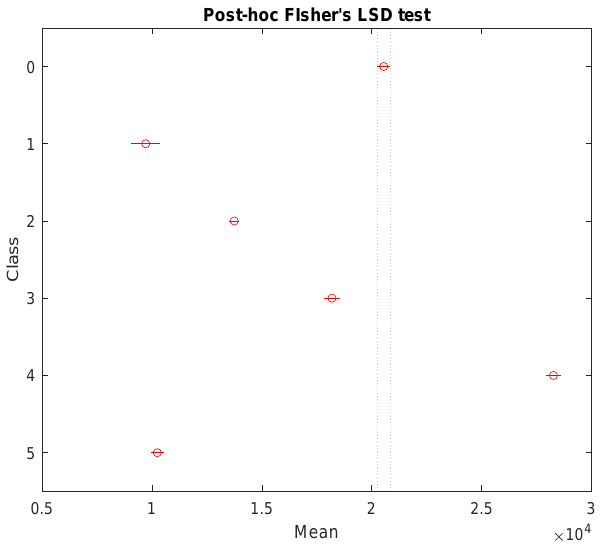
Figure 3. Results of ANOVA post-hoc test obtained using the whole